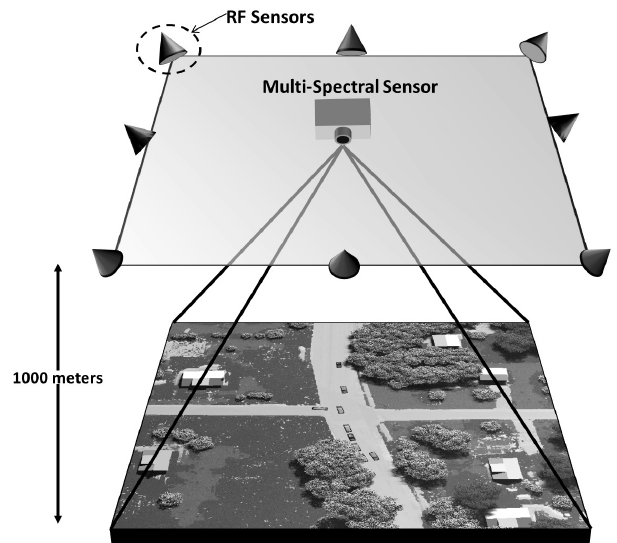
Figure 1. Geometry of the multi-spectral and RF sensors in reference to the plane in which the moving vehicles lie.